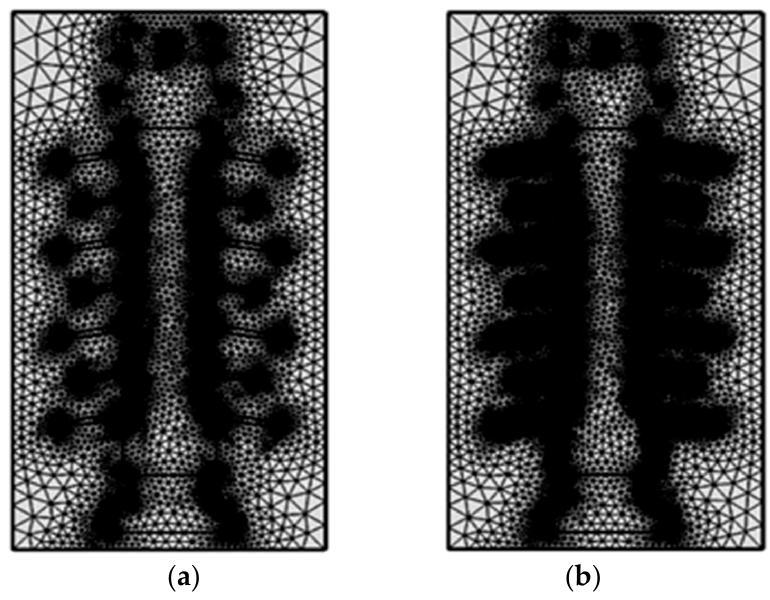
Figure 2. The insulator triangle element ( a ) without pollutant and ( b ) with